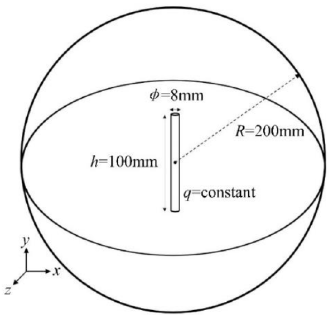
Figure 1. Geometric model of the natural convection of supercritical helium in a spherical